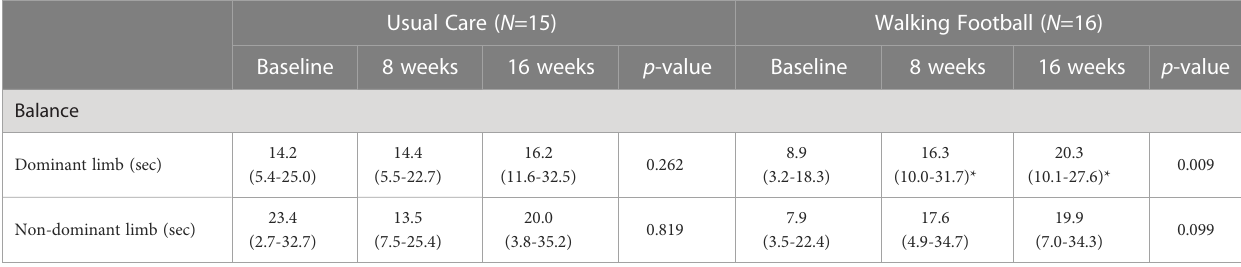
TABLE 4 Changes over time in balance in walking football and control